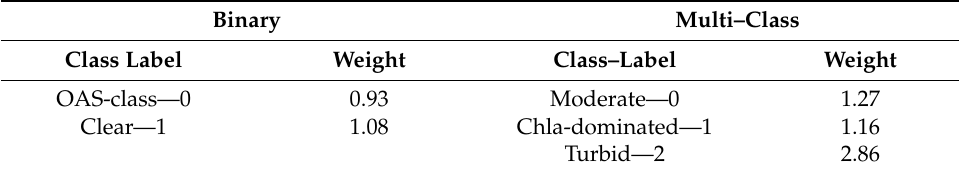
Table 2. Class weights used when constructing the